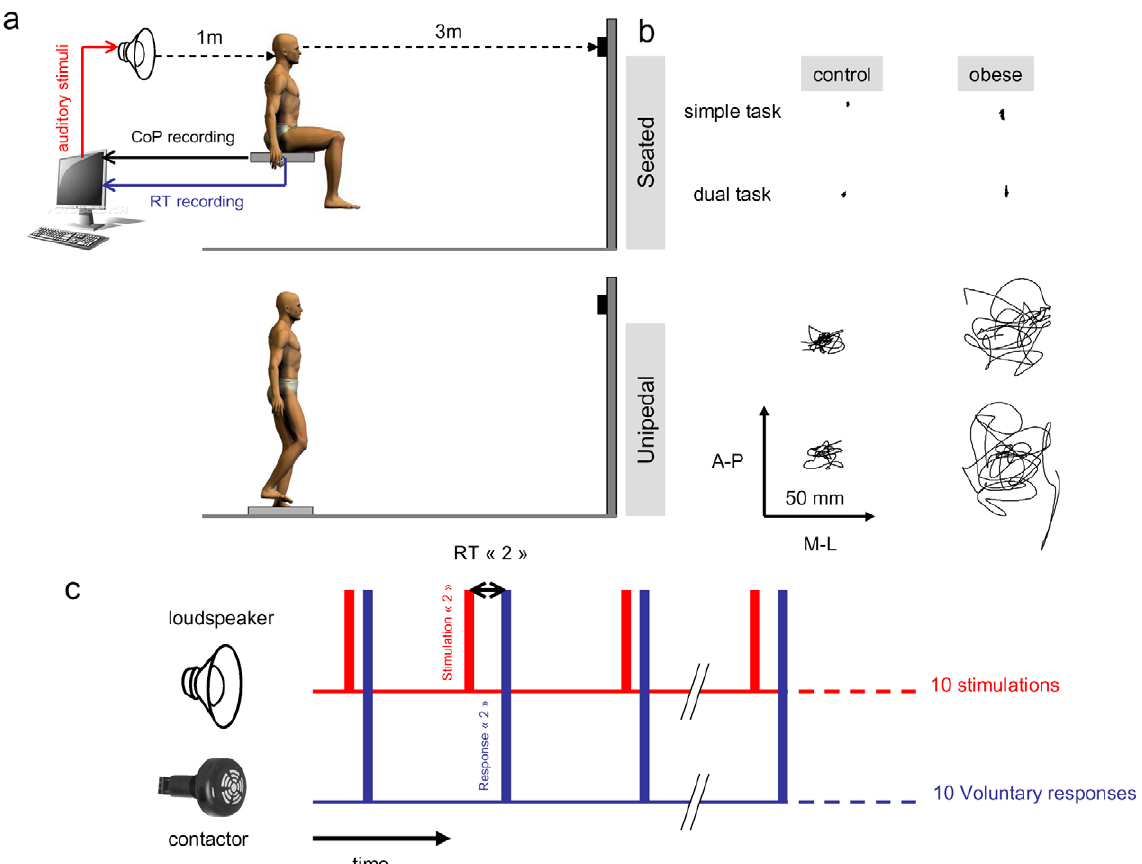
Figure 1. Experimental setup (a). Illustration of CoP displacement on the AP and ML axes in the single and dual-task conditions in the seated and unipedal postures for a non obese and obese patient (b) . Auditory stimulus representation and motor response via the contactor. At each stimulus was associated a RT defined as the time difference between the signal peak of stimulation and the motor response (c) . doi:10.1371/journal.pone.0014387.g001 PLoS ONE |